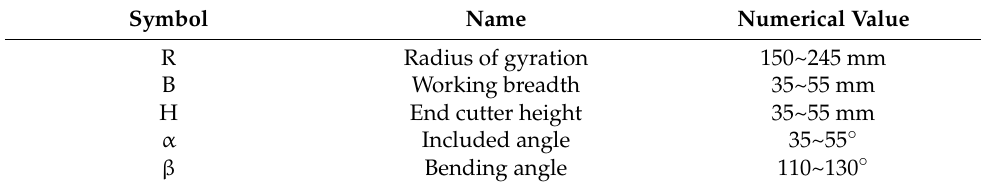
Table 1. The main structural